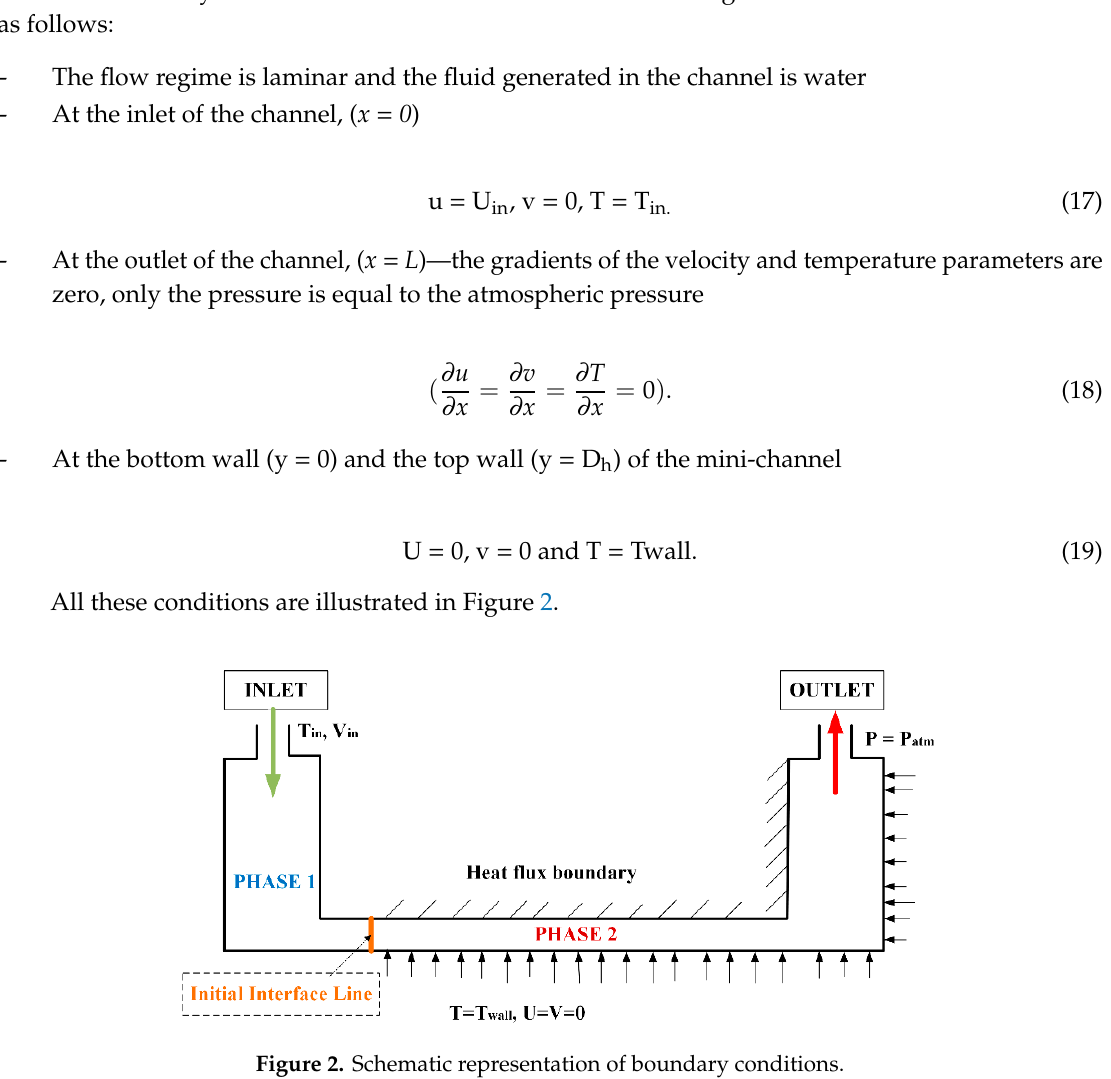
Figure 2. Schematic representation of boundary conditions.